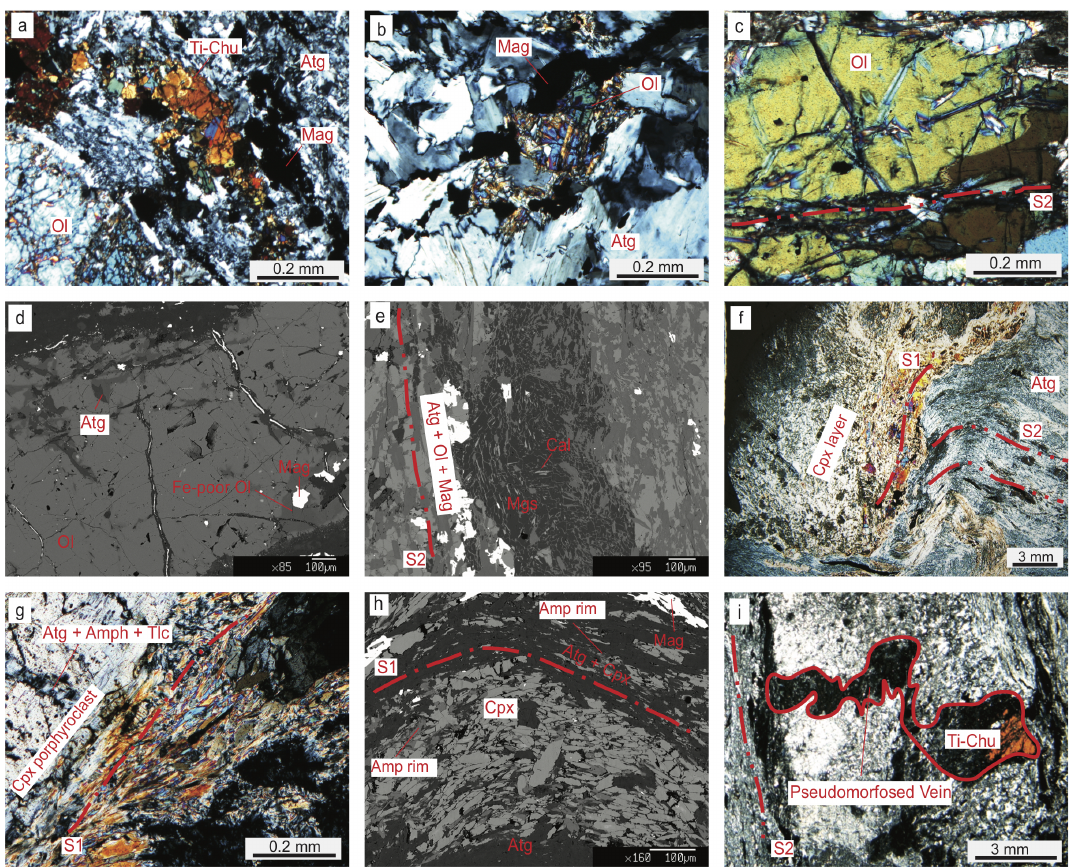
Figure 7. ( a ) Polygonal aggregate with twinned Ti-Chu and Mag between an Ol layer and the foliated (S2) matrix of Atg. Crossed polars. ( b ) Close up on Ol relic inside an ex-porphyroclast of Ol replaced by Atg and Mag, in a serpentinite with Ol porphyroclasts. Crossed polars. ( c ) Ol porphyroclast re-oriented parallel to S2 foliation with fractures filled by Atg. Crossed polars. ( d ) BSE image of a Ol porphyroclast with Fe-poor reaction-zones at the boundary with Mag and Atg. ( e ) BSE imagine of Mgs + Cal aggregates texture with Atg + Ol + Mag at the margin with Ol-rich domains that mark S2 (Serpentinite with Ol porphyroclasts). Crossed polars. ( f ) Geometric relationship between Cpx layer, S1 foliation marked by Cpx and Amp and the foliated (S2) and crenulated (D3) mylonitic matrix. S2 foliation is marked by Atg SPO, elongated Mag + Chl aggregates. Crossed Polars. ( g ) Detail of the Cpx layer with the S1 foliation marked by Cpx and Amp SPOs, Cpx porphyroclast is cut by post-D2 fractures filled with Atg + Amp + Tlc. Crossed polars. ( h ) BSE image of a layer of Cpx + Amp + Atg marking S1 foliation (serpentinite with Cpx layer). ( i ) Crenulated contact between a possibly pseudomorphosed Ti-Chu granoblastic vein replaced by randomly oriented Atg and Mag; S1 foliation, is well preserved in the microlithons of S2, marked by Atg